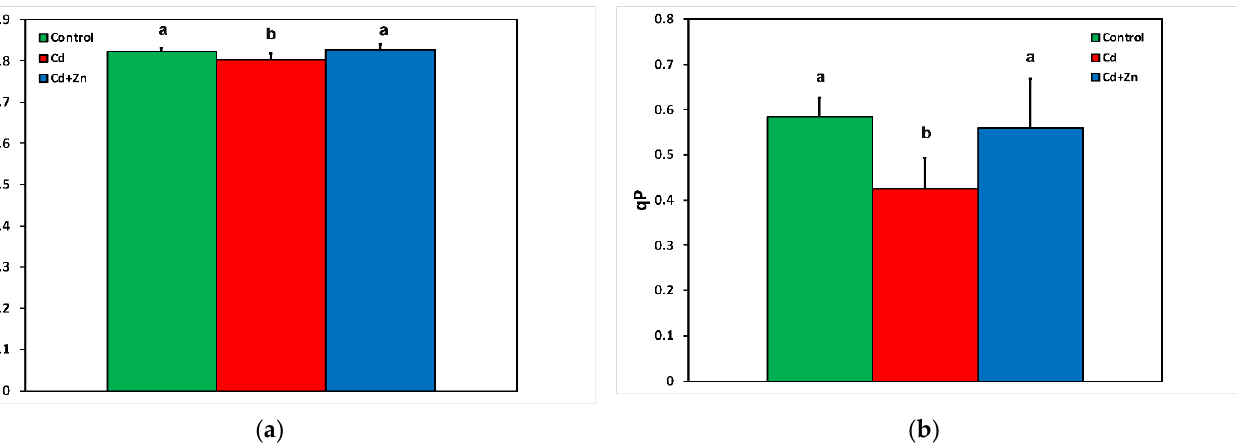
Figure 3. Changes in the maximum efficiency of photosystem II ( Fv / Fm ) ( a ), and the redox state of quinone A (Q A ), an estimate of the fraction of open PSII reaction centers estimated at 900 μ mol photons m –2 s –1 actinic light (AL) intensity ( qp ) ( b ), of Salvia sclarea control (nutrient solution), Cd 2+ (nutrient solution +100 μ M Cd 2+ ), and Cd 2+ + Zn 2+ (nutrient solution +100 μ M Cd 2+ + 900 μ M Zn 2+ ). Error bars are standard deviations ( n = 5). Columns with different lowercase letters are statistically different ( p < 0.05).